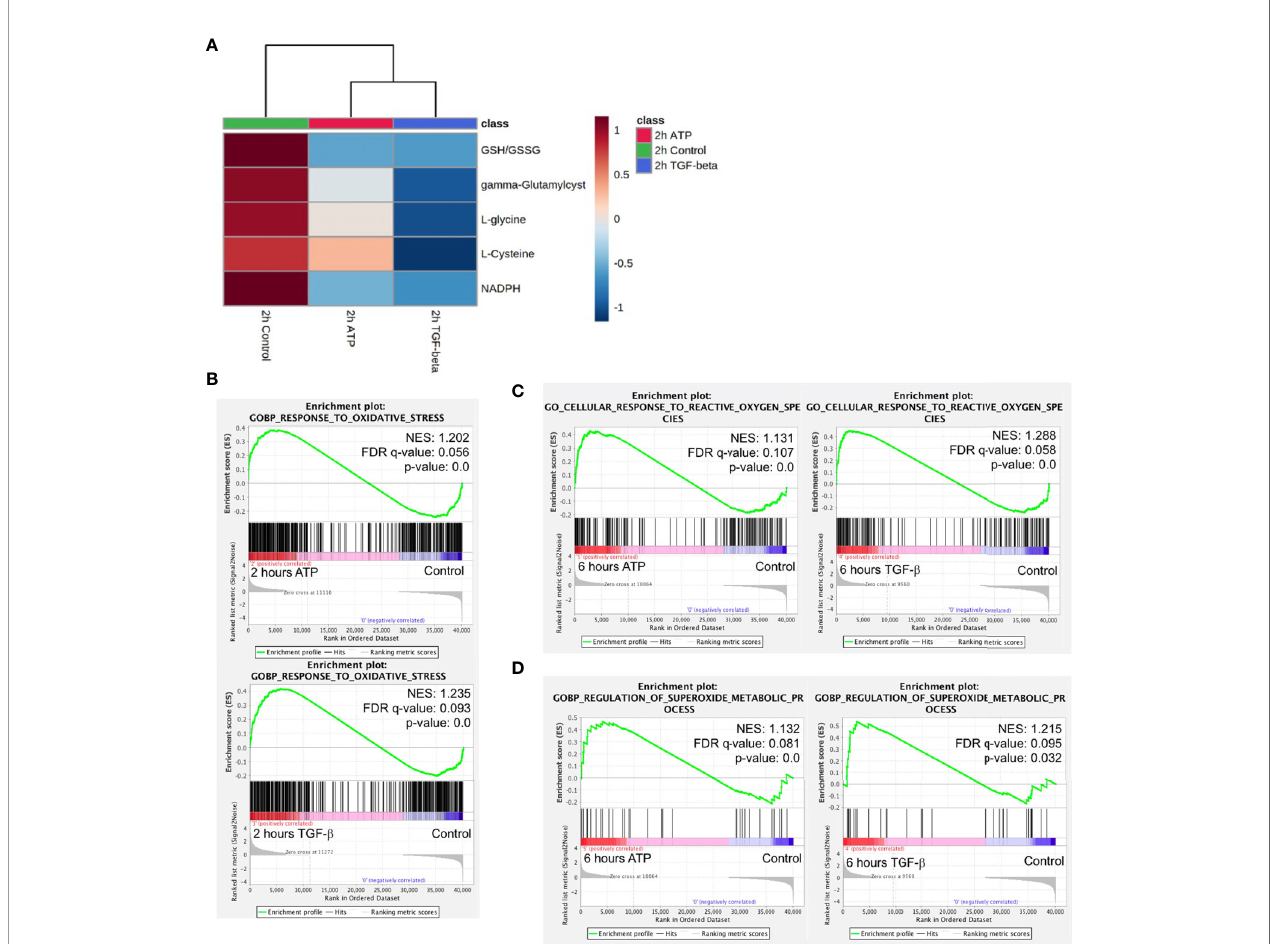
FIGURE 7 | Mechanism study III: similarity and difference between eATP and TGF- b in ROS-related metabolites and genes. A549 cells were treated with either ATP or TGF- b for 2 hours. Then analyzed for their respective transcriptome and metabolome pro fi les. (A) Heatmap of major metabolites involved in the ROS pathway and GSH/GSSG ratio (a marker for redox homeostasis in cancer cells). (B – D) GSEA of RNAseq data for the enrichment of oxidative stress (B) , cellular response to ROS (C) , and superoxide metabolism (D)